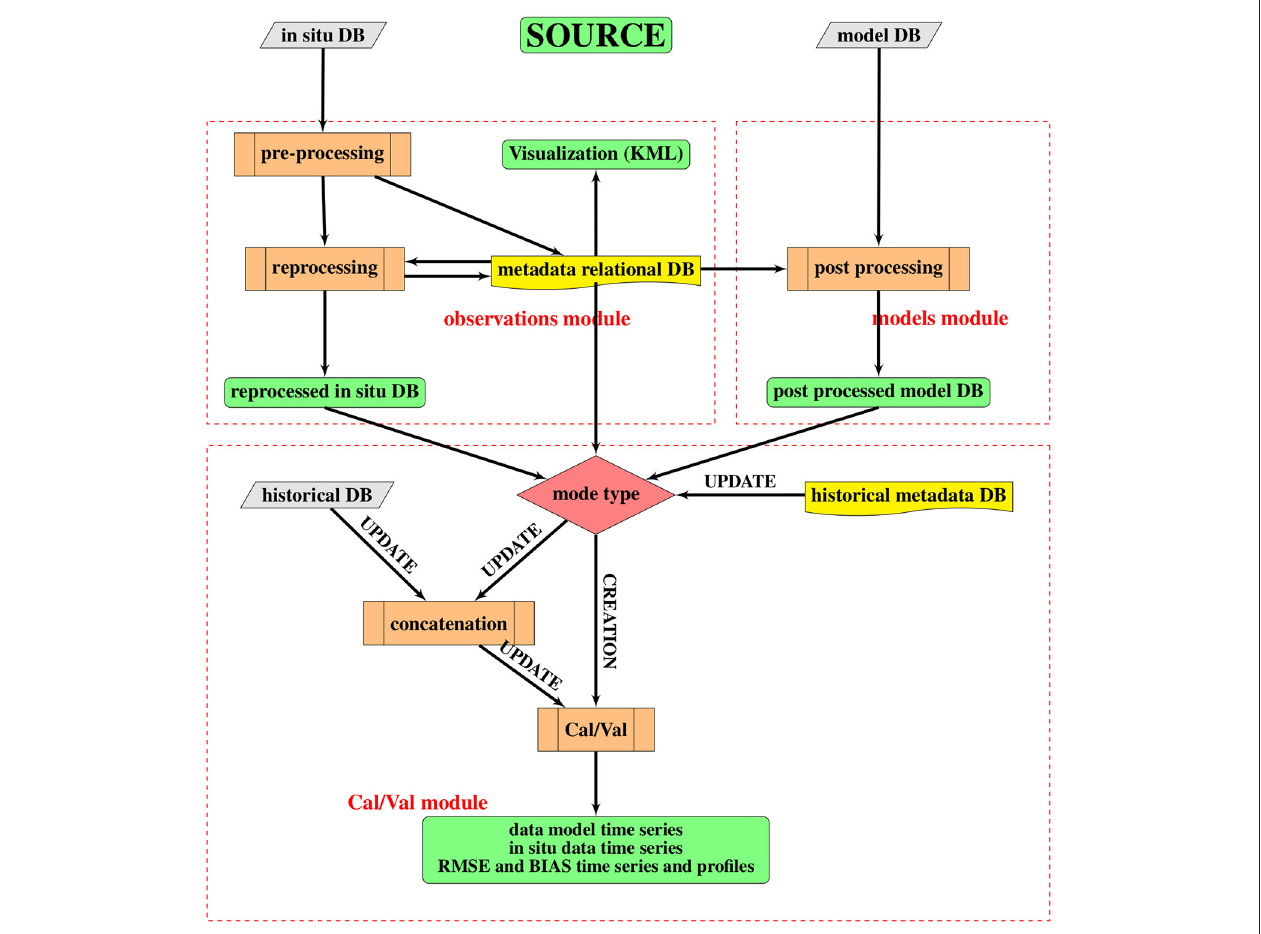
FIGURE 3 | Flow chart of SOURCE functioning structure. The red dashed rectangles represent the three different modules. Gray parallelograms are inputs, brown rectangles are internal operations, green ellipses are outputs, yellow prints are metadata DB or logging, and orange double rectangles are the main routines. The red rhombus represents the choice between CREATION or UPDATE